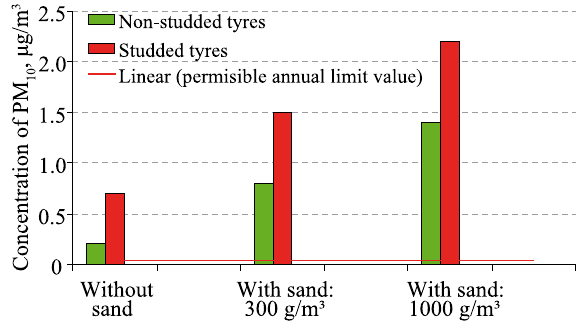
Fig. 6. Dependency of PM 10 emission concentration on the type of tyres and the amount of sand spread by Johansson 2006